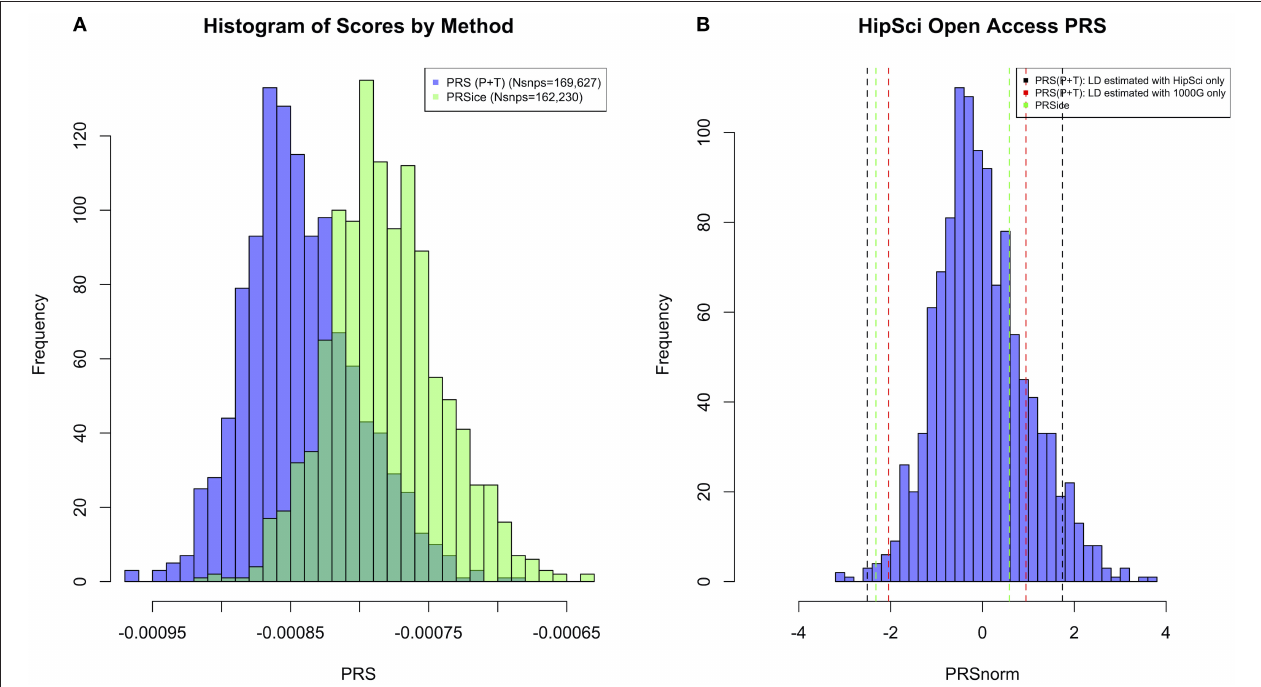
FIGURE 2 | (A) Histogram of PRS Scores in HipSci (19) open access data + 1,000 Genomes data (18) for both PRS(P + T) and PRSice methods. Only SNPs with p ≤ 0.5 are included in the score, and a clumping threshold of 0.1 was used. (B) Histogram displaying PRS extremes using PRS(P + T) estimating LD in HipSci ( 19) data. Additional vertical lines display the PRS of the same two individuals when LD is estimated from a different sample, or PRS is computed using a different method.